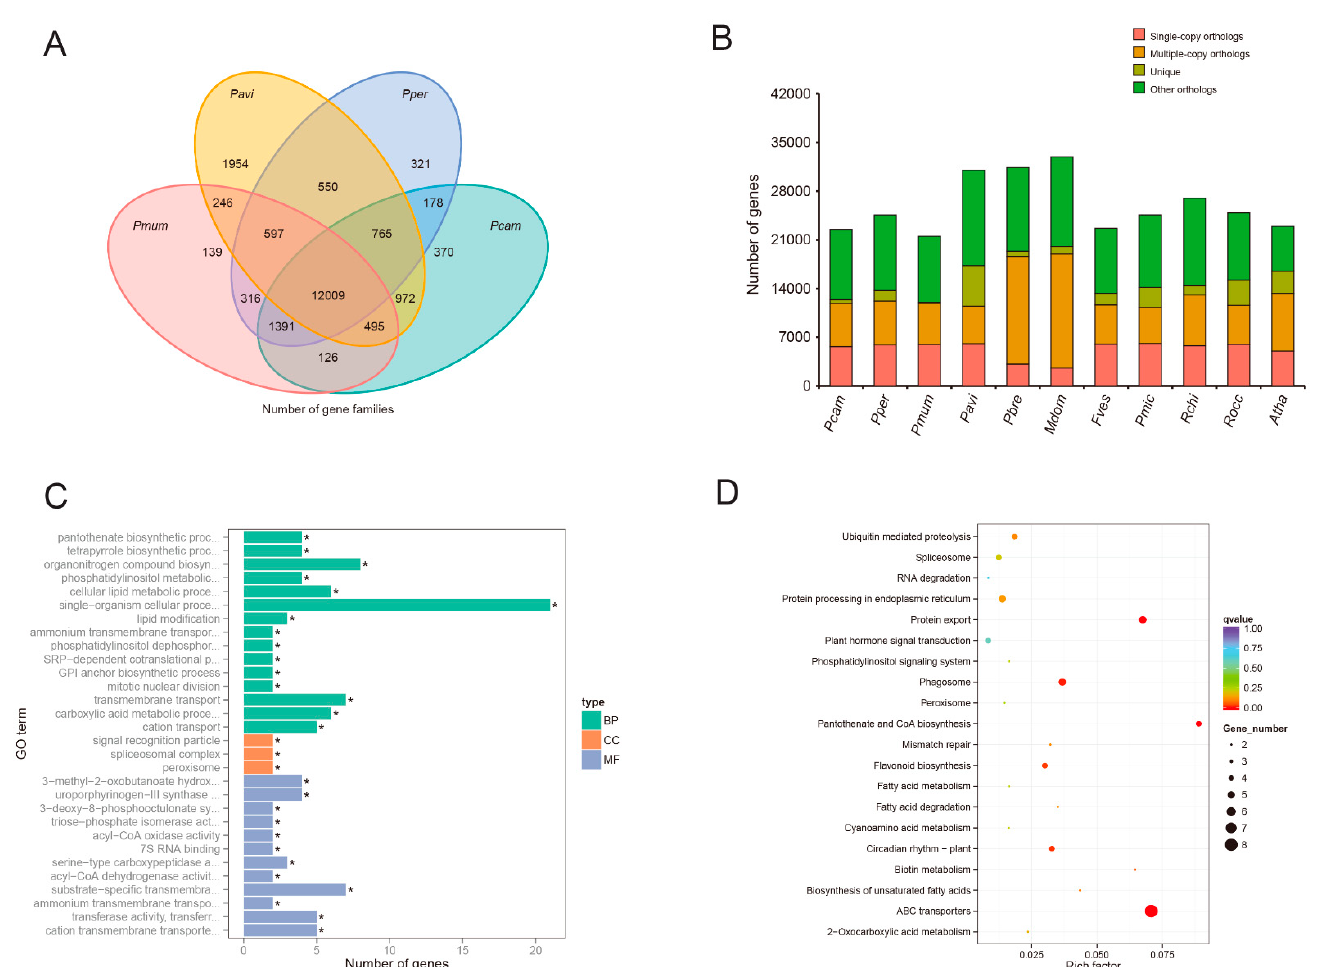
Figure 4. Gene family analysis of the genome of P. campanulata . ( A ) The unique and shared gene families among four species. Pcam: P. campanulata ; Pper: P. persica ; Pmum: P. mume ; Pavi: P. avium . ( B ) Comparison of orthologs between P. campanulata and other angiosperm species. Pcam: P. campanulata ; Pper: P. persica ; Pmum: P. mume ; Pavi: P. avium ; Pbre: P. bretschneideri ; Mdom: M. domestica ; Fves: F. vesca ; Pmic: P. micrantha ; Rchi: R. chinensis ; Rocc: R. occidentalis ; Atha: A. thaliana . ( C ) GO enrichment